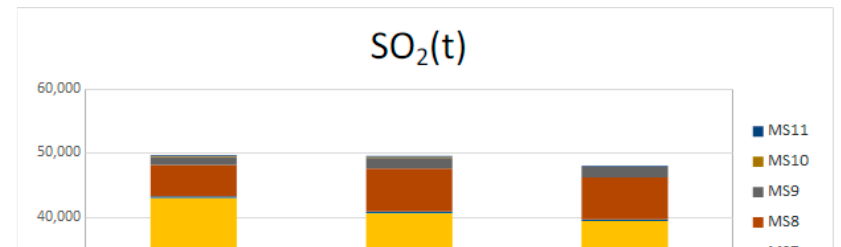
Figure 4. Emission scenarios for NH 3 .